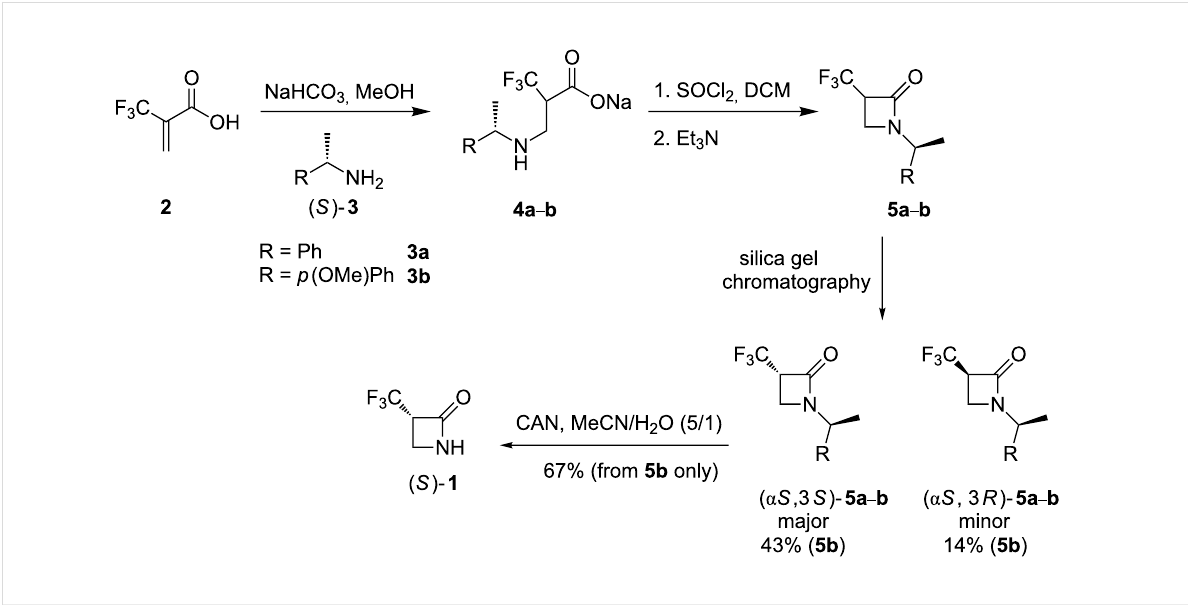
Scheme 1: Synthetic route involving a diastereoisomeric separation to α -(trifluoromethyl)- β -lactam (( S )- 1 ) from α -(trifluoromethyl)acrylic acid 2 and ( S )- α -( p -methoxyphenyl)ethylamine ( 3b ). Yields are quoted for the conversion of 4b .